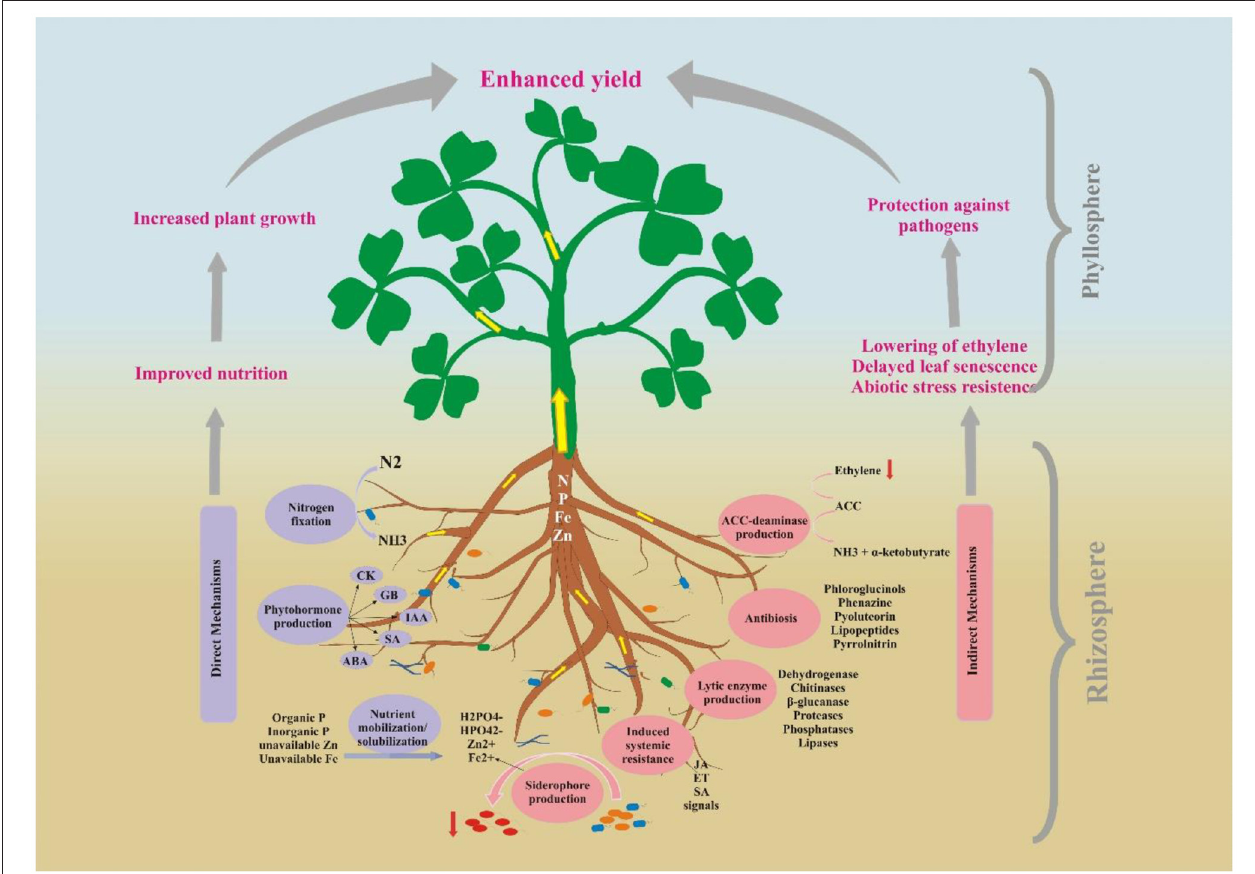
FIGURE 2 | The benefits of PGPR-mediated rhizosphere engineering to the plant